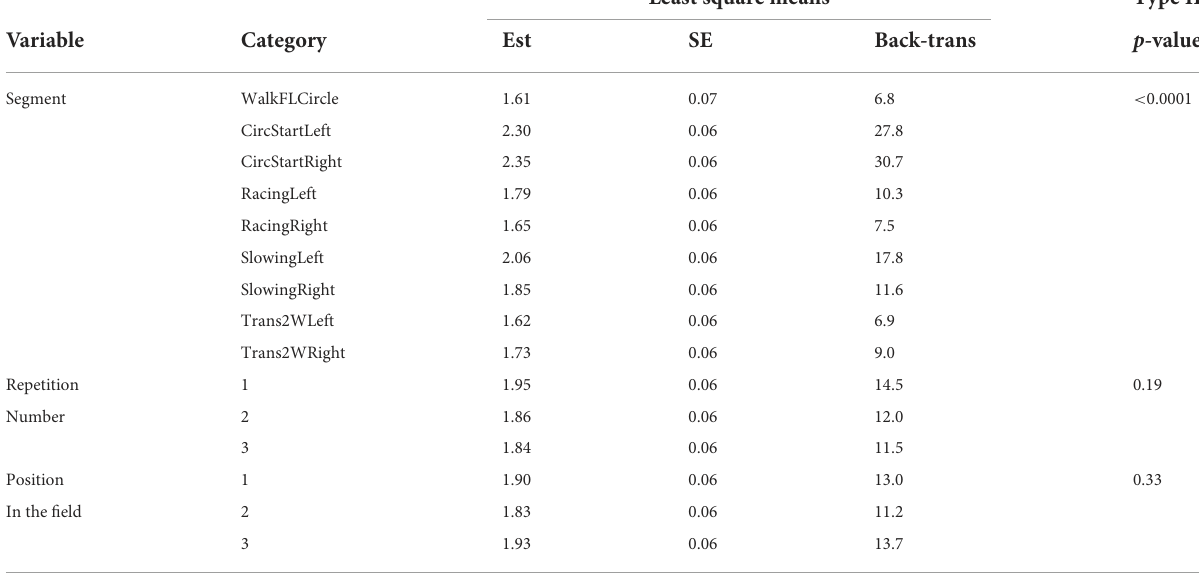
TABLE 4 Least square means (478 observations, 11 drivers and 9 horses) from model results with segment interquartile range rein tension as the outcome variable (modeled fourth-root transformed) and p -values for the corresponding main